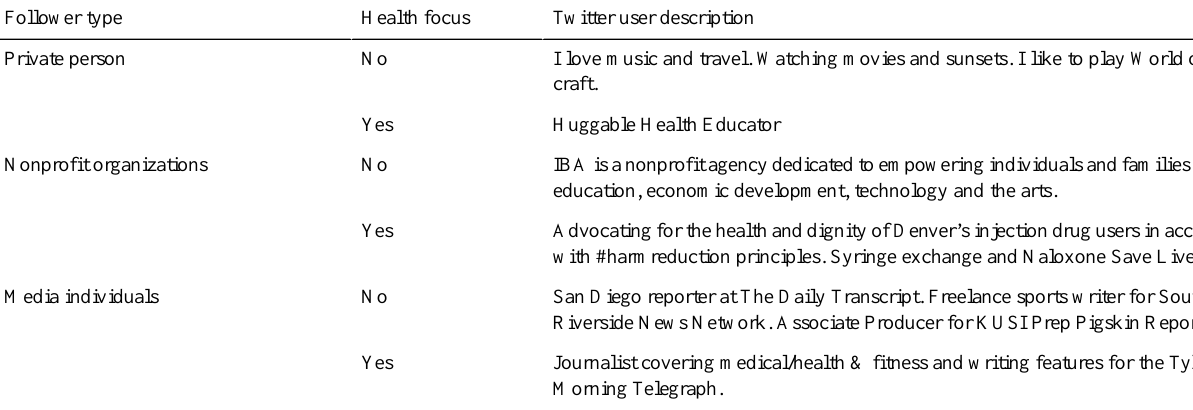
Table 2. Examples of common categories of local health department Twitter followers.